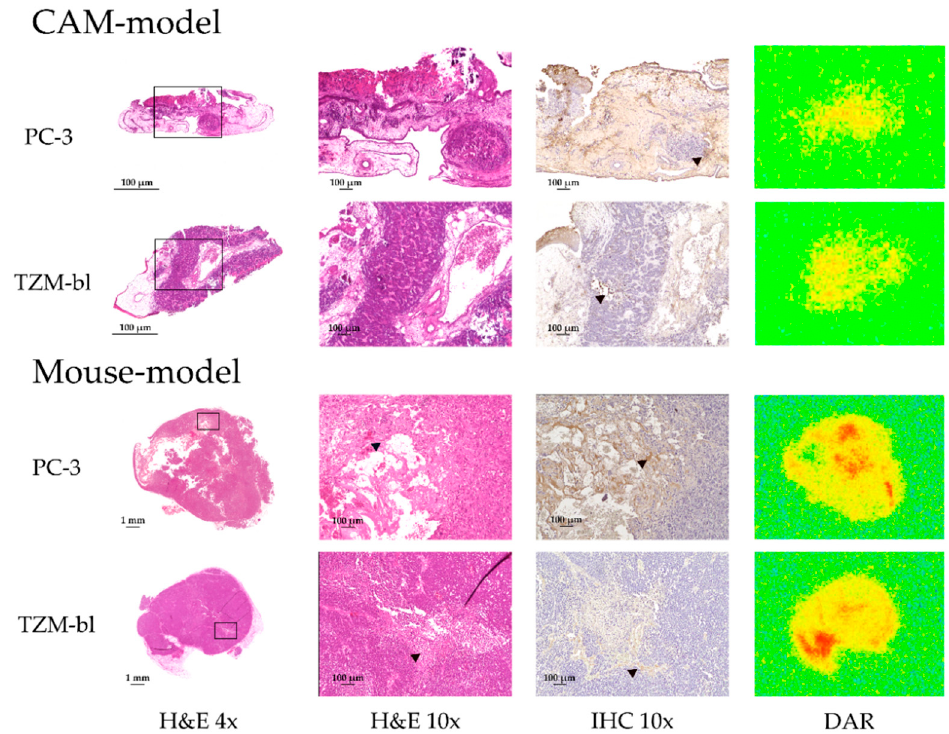
Figure 7. Microscopic and DAR images of histological sections of PC-3 and TZM-bl tumors of both xenograft models: In the H&E images, obvious necrotic areas (black arrow) were observable in the tumors from the mouse model. In the subsequent IHC sections, [ 89 Zr]Zr-DFO-HSA accumulation was clearly visible at the same locations (brown color precipitate, black arrows). The areas stained in the IHC correspond to the regions with strong radioactivity enrichment in the DAR (coded in red). Similar areas were not noted in the tumors of the CAM model, having a more homogeneous distribution of zirconium-89 activity and HSA. In general, IHC could verify the accumulation of [ 89 Zr]Zr-DFO-HSA due to the EPR effect.